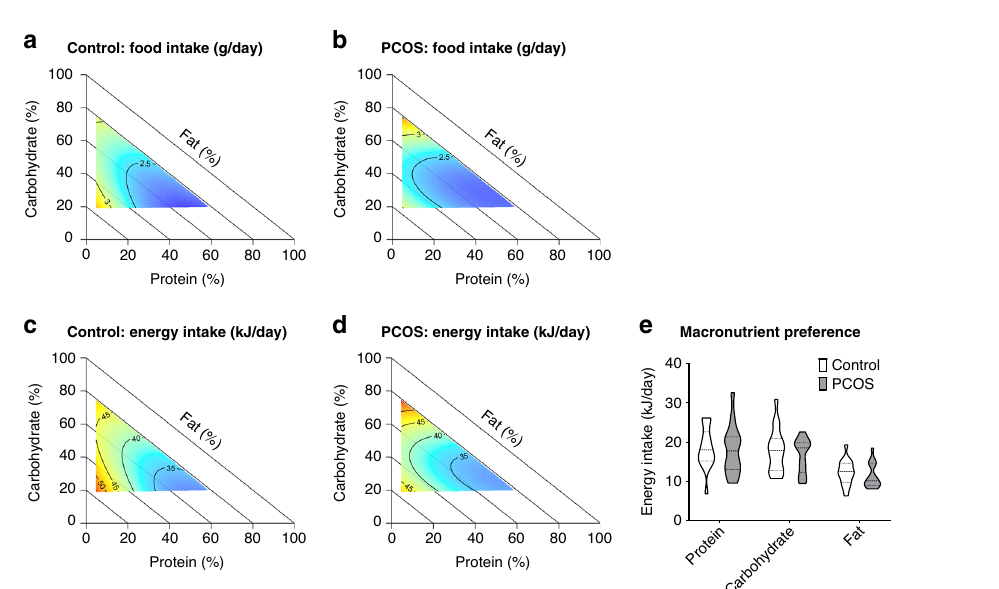
Fig. 3 PCOS and control mice exhibit similar eating habits and dietary preference. Response surfaces showing food intake of control ( a ) and PCOS ( b ) mice and energy intake of control ( c ) and PCOS ( d ) mice across 10 different diets varying in protein (P), carbohydrate (C), and fat (F) content, demonstrating that PCOS mice exhibit the same eating pattern as control mice, as dietary protein increases, food and energy intake decreases. Red areas indicate the greatest value for each response, which then decreases to the lowest value as the color shifts to blue. a – d n = 93 control and 94 PCOS mice. e Macronutrient intake (kJ/day) of control and PCOS mice when given a choice between 3 diets (high P (60%), high C (75%), and high F (75%)), showing no signi fi cant difference in macronutrient preference between control and PCOS mice. e n = 17 control and 16 PCOS mice. e Data presented as violin plots, doted lines indicate the median and dashed lines the 25 and 75%